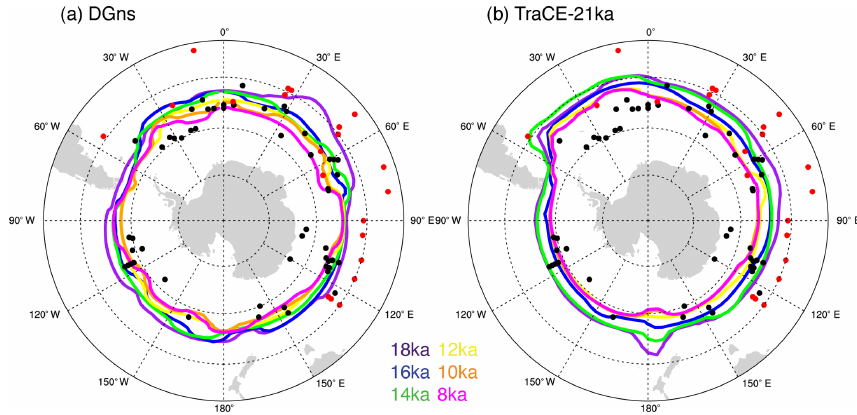
Figure 9. Modelled austral winter sea ice extent (15% coverage contour) per 2kyr for (a) DG ns and (b) TraCE-21ka from 18 to 8ka (maximum latitude of 35 ◦ S). Dotted lines indicate latitude (intervals of 15 ◦ ) and longitude (intervals of 30 ◦ ). The circles refer to marine sediment core sites with black circles corresponding to sites that indicate the presence of winter LGM sea ice, whereas the red circles represent sites that indicate no presence of winter LGM sea ice (adapted from Gersonde et al., 2005).